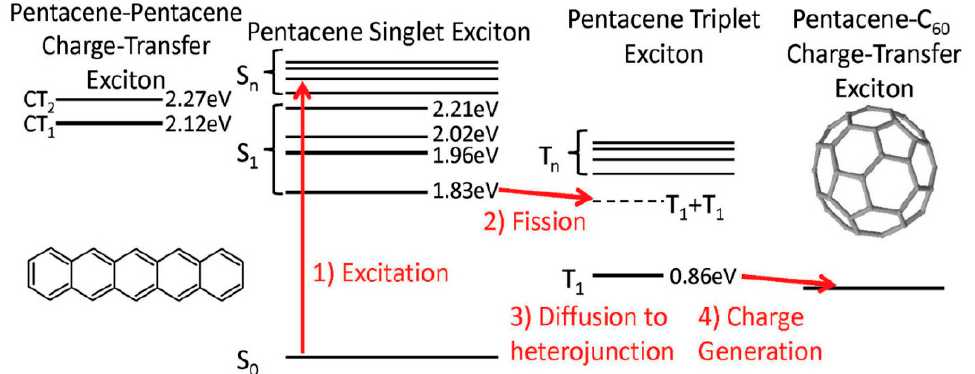
Figure 11. Molecular structures of pentacene and C 60 and an energy level diagram for excitonic states in pentacene. Reprinted with permission from Ref. [91]. Copyright 2010, American Chemical Society.